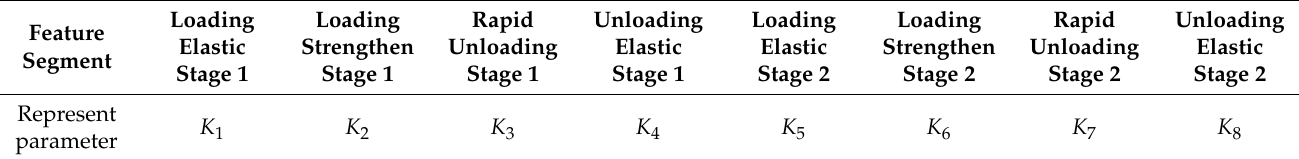
Figure 16. Feature segments of hysteresis curves. Table 6. Parameters of each feature segment.